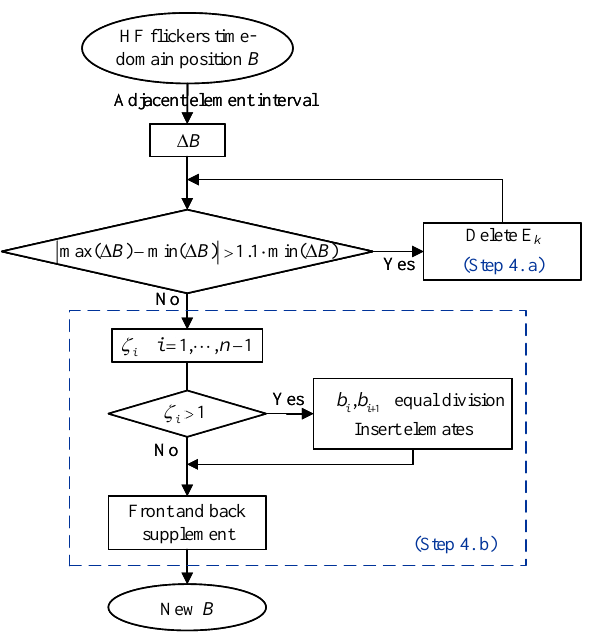
Figure 9. Process of the high-frequency flicker time domain coordinate